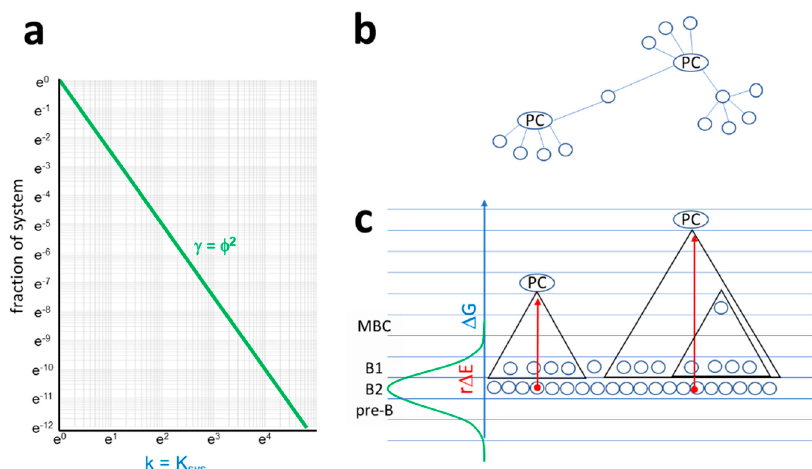
Figure 6. Properties of the antibody interaction network. ( a ) In the antibody network, a node is a B cell at a particular di ff erentiation stage and a given BCR sequence. Links are pathways of antibody–antigen interactions, along which antigen is transferred from a lower energy node to a higher energy node. Degree distribution of the antibody network corresponds to the probability distribution of relative free energy of antibody interactions, where the system equilibrium constant is the degree of node and Ni / N is relative frequency of nodes with that degree in the interaction network. ( b , c ). A schematic network organization of antibody interactions is proposed. In subnetworks, plasma cells act as hubs, being connected to all memory B cells and B1 cells with shared structures at lower free energy levels. By secreting antibodies, plasma cells control activation of all connected cells. Triangles represent subnetworks, blue lines indicate energy levels, and red arrows stand for energy deviation.